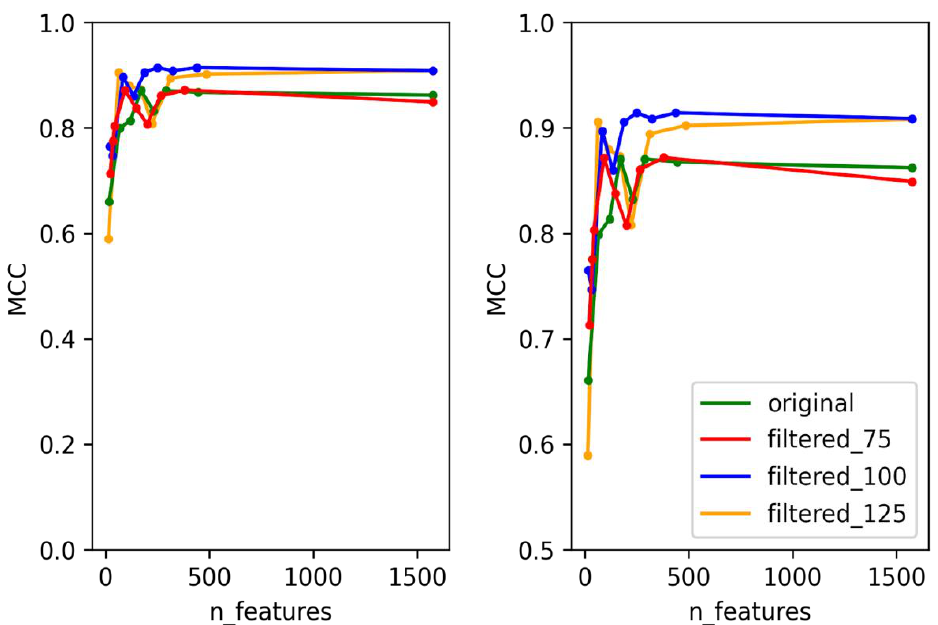
Figure 3. Test MCC of Cro/CI predictor using original dataset and filtered datasets using different numbers of features. Graph on the right shows the magnified section of the original graph with MCC ranging from 0.5 to 1.